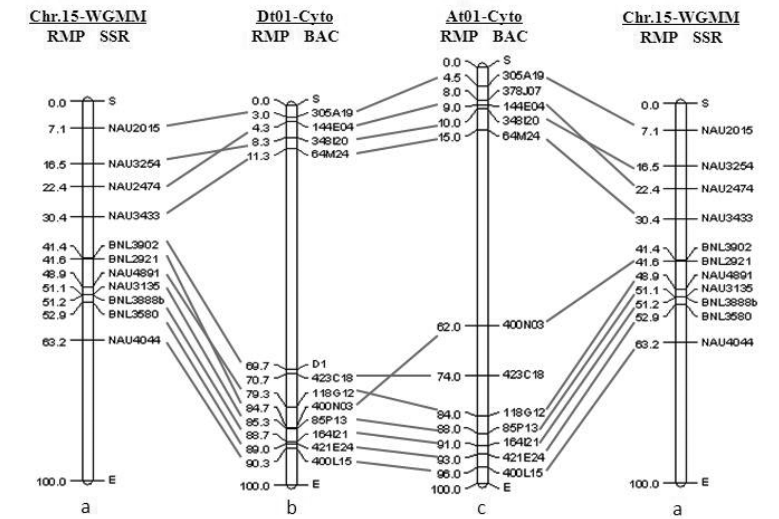
Figure 2. Comparison of positions of BACs in cytogenetic maps of G. hirsutum A positions of SSR markers a Positions of SSR markers based on WGMM; c, b Cytogenetic maps of G. hirsutum A 01/D 01. h h